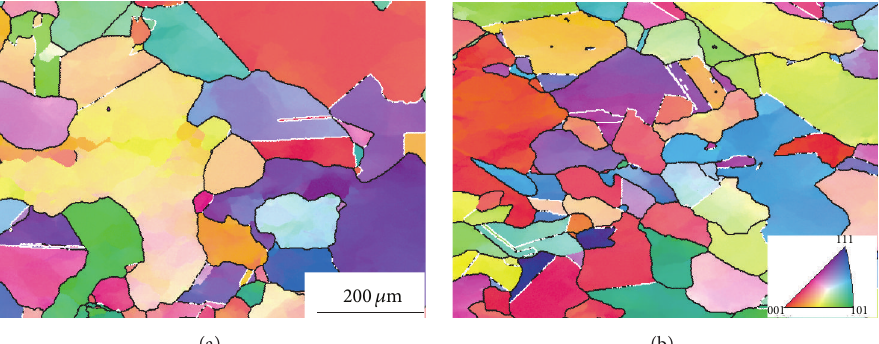
Figure 8: Microstructure of 316LN steels with different N contents deformed at 1473 K and 0.001s −1 : (a) 08N (b) 17N.